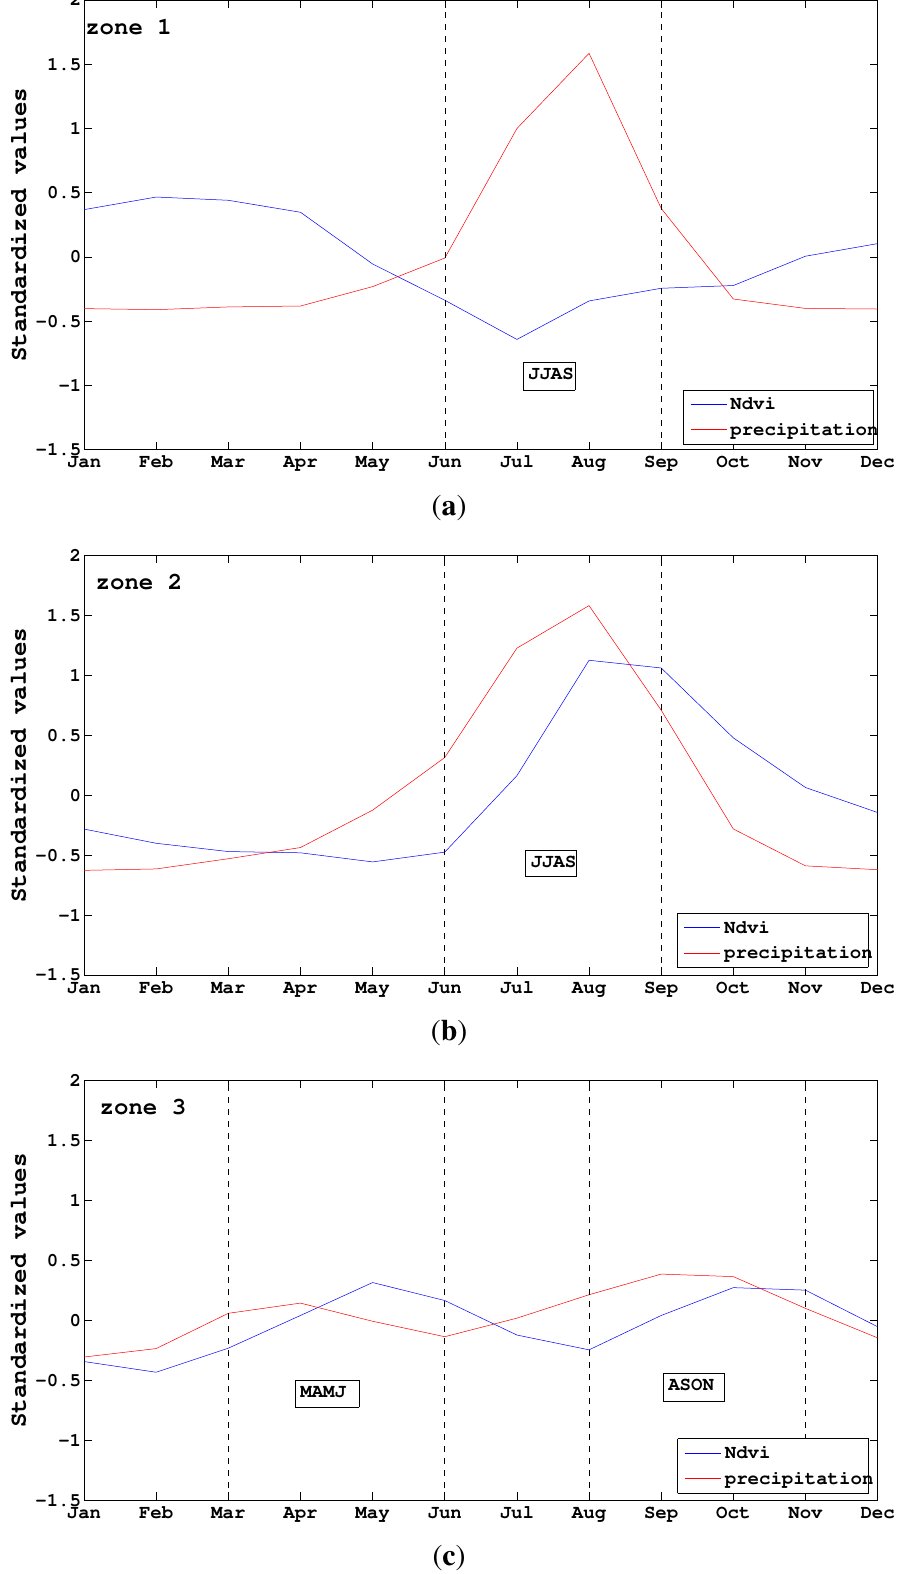
Figure 3. Intra-annual variability of yearly averages of NDVI (blue solid line) and precipitation (red solid line) within the 1982–2000 period over each vegetation